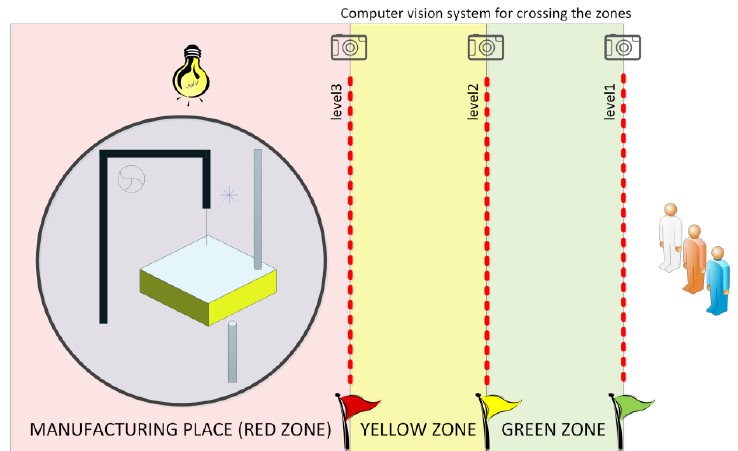
Figure 4. A case study example of a manufacturing cyber-physical system.